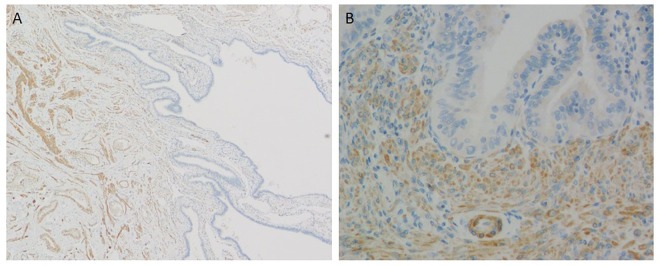
Filamin A expression in the human fallopian tube.A. low-power view, B. high-power view. Filamin A is expressed in smooth muscle bundles of the tubal wall. The immunoreactivity of the epithelium for filamin A is undetectable or only faint in the tubal epithelium.